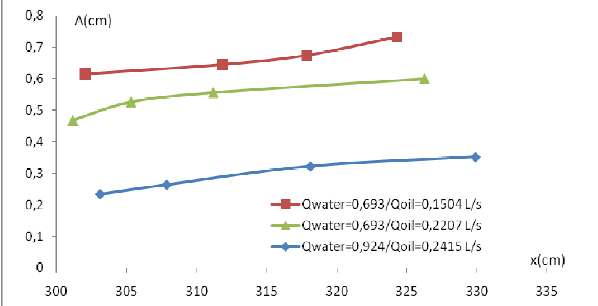
The following results were obtained with the Blasia P 1000 oil. The amplitude increases with x, as shown in fig.8 while it decreases with increasing Q water or Q oil as shown in fig.9 or channel